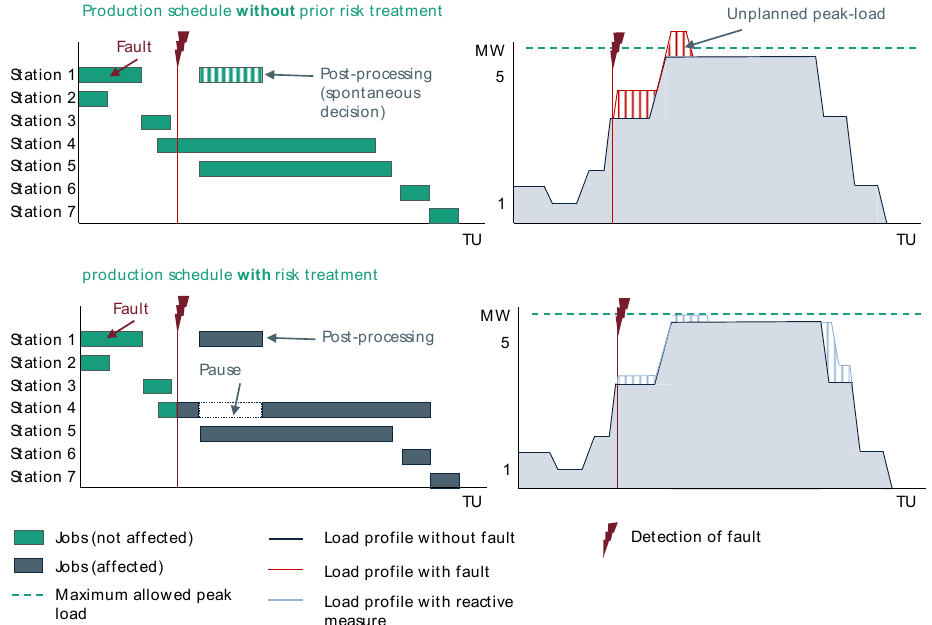
Figure 5. Schematic initial production schedule and the effects of disturbances on the load profile.